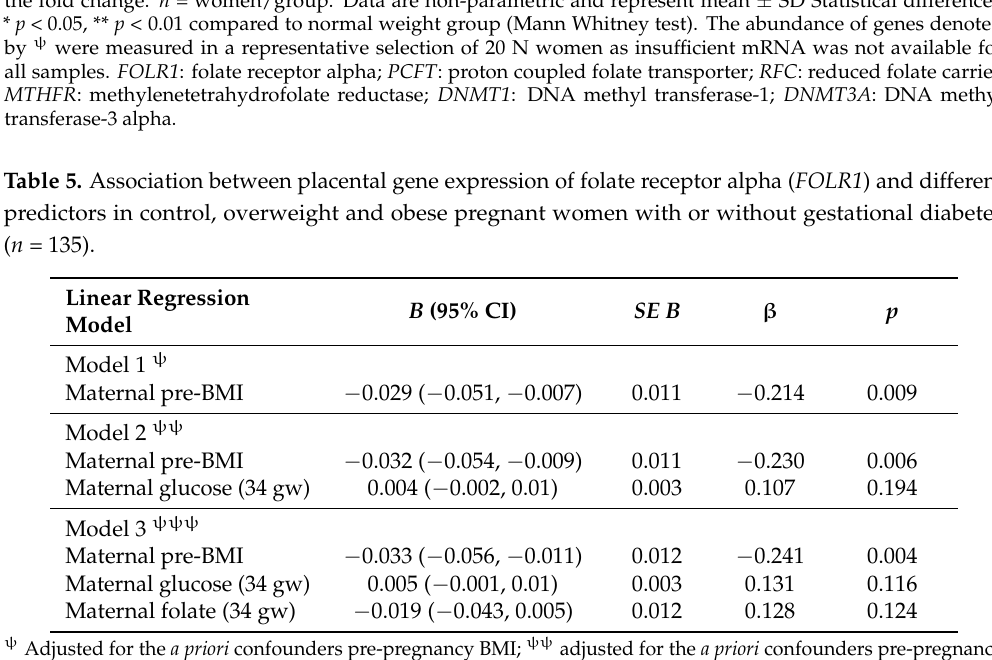
Table 4. Effects of maternal body mass index on gene expression markers of folate transport and metabolism and DNA methylation in placenta of normal weight (N), overweight (OW), obese (O), gestational diabetic, normal weight (GDN) and gestational diabetic, obese (GDO) pregnant women. NCBI Target N OW O GDN GDO Pathway Sequence Gene ( n = 59) ( n = 29) ( n = 21) ( n = 14) ( n = 11) NM_016725.2 FOLR1 1.0 ± 0.9 0.8 ± 0.6 PCFT ψ Folate transport and metabolism DNA methylation